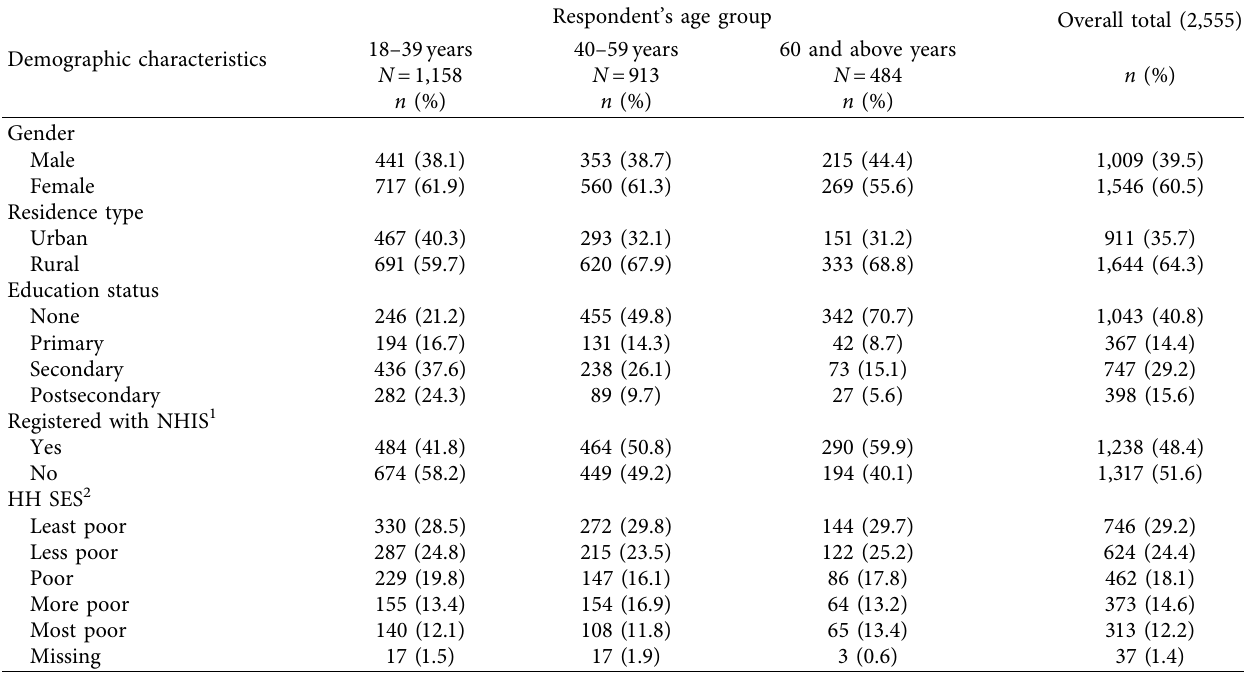
Table 1: Distribution of respondents’ basic demographic characteristics.